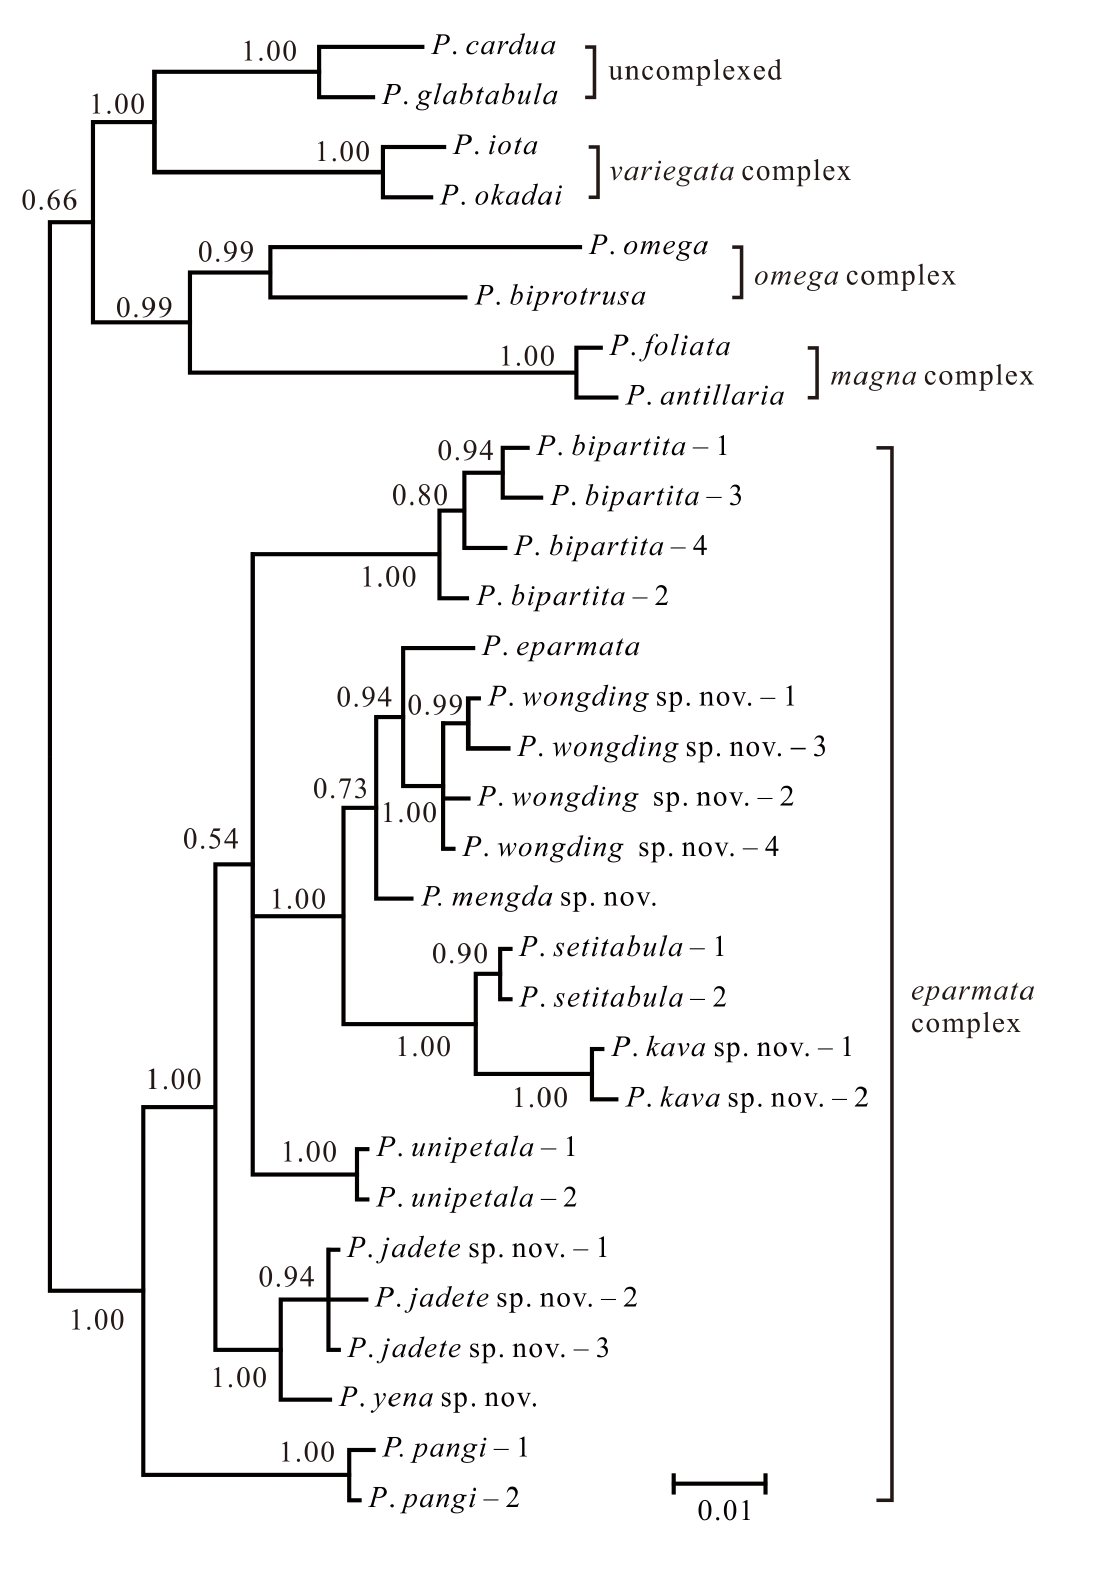
Fig. 1. Bayesian tree based on the combined data of COI gene. Numbers around the node indicate the Bayesian posterior probability; results lower than 0.5 are not